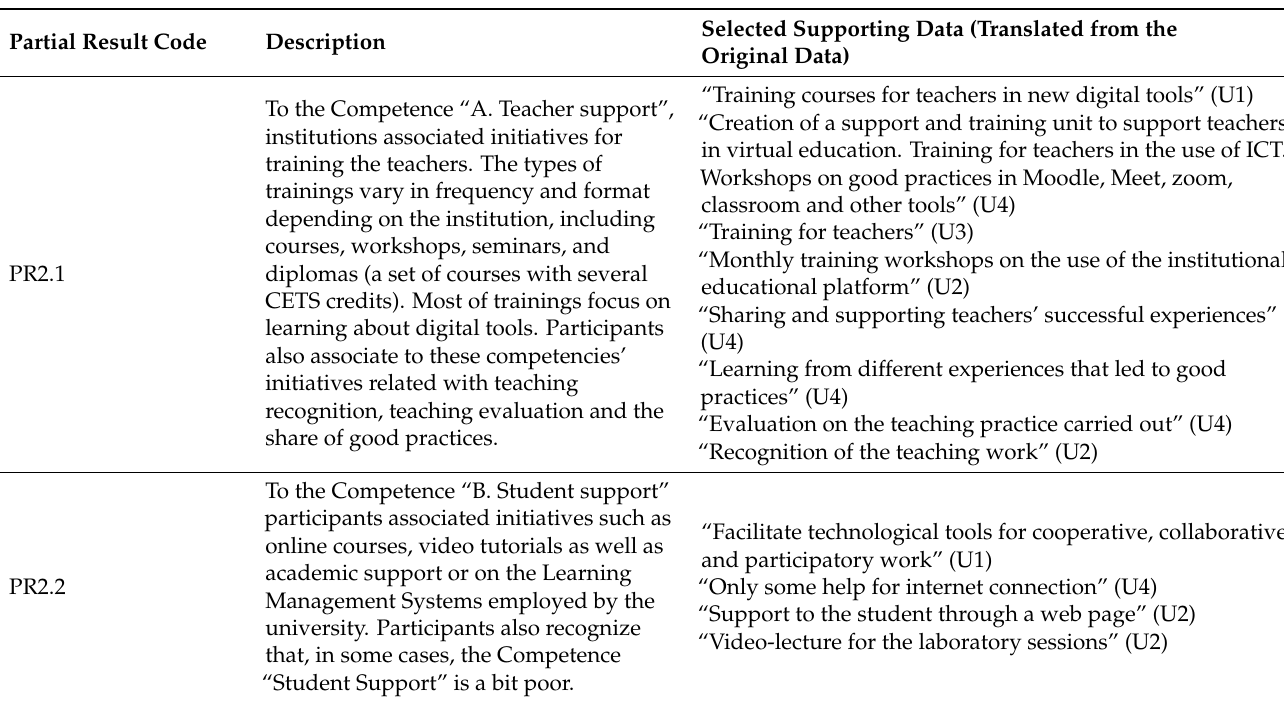
Table A5. Partial results analysis of the data collected through the [Poster Initiatives Classification], corresponding to the second activity of the first